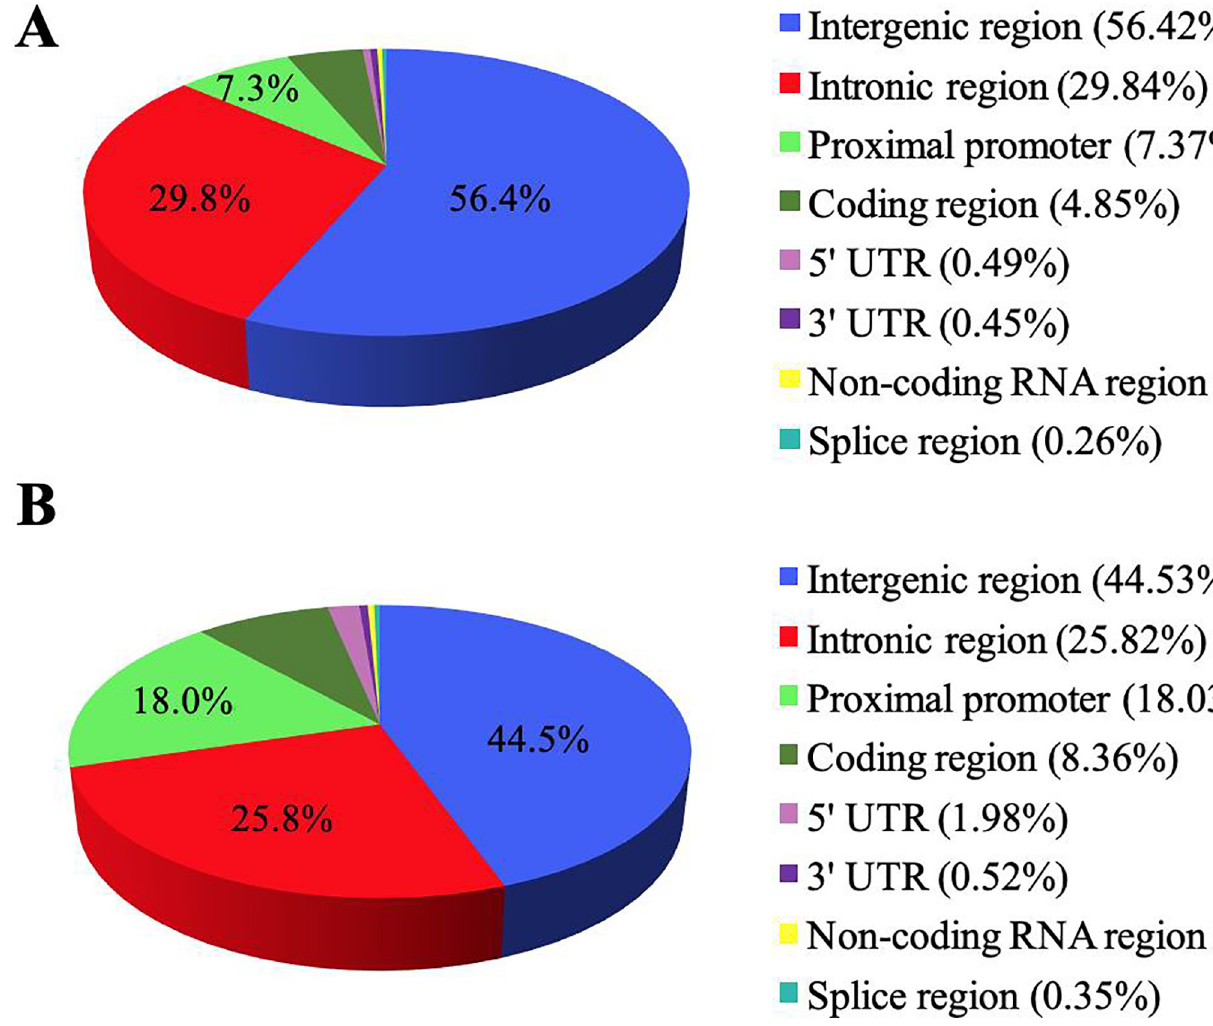
Fig 5. Classification of meSNPs located within CGIs. Genomic distribution of meSNPs identified in (A) relaxed, and (B) strictly defined